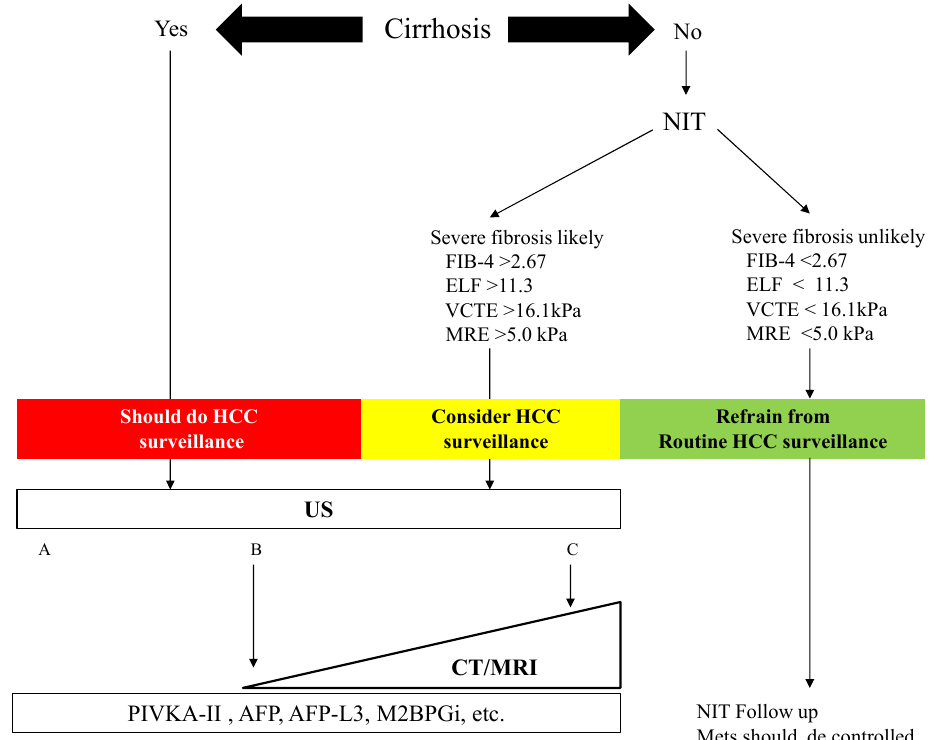
Figure 3. Algorithm for HCC surveillance in Nonalcoholic Fatty Liver Disease. NIT: noninvasive test, FIB-4: fibrosis-4, ELF: enhanced liver fibrosis, VCTE: vibration-controlled transient elastography, MRE: magnetic resonance elastography, HCC: hepatocellular carcinoma, US: ultrasonography, CT: computed tomography, MRI: magnetic resonance imaging, PIVKA-II: protein induced by vitamin K, AFP: α -fetoprotein, M2BPGi: Mac-2 binding protein glycosylated isomer. Mets: metabolic syndrome.